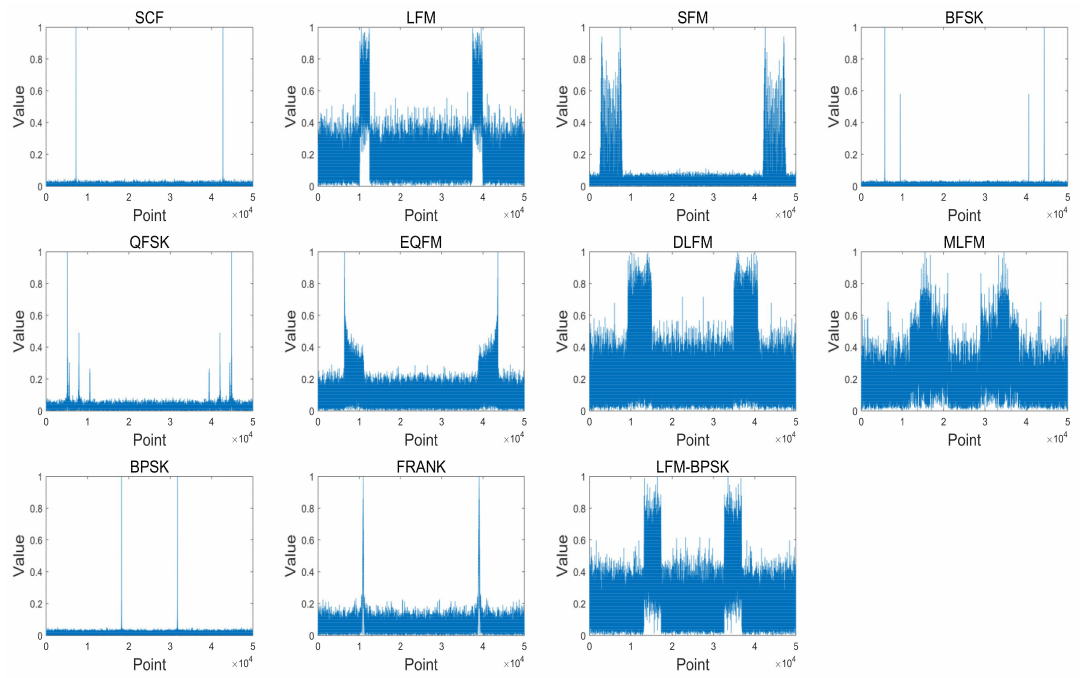
Figure 4. The frequency-domain amplitude spectra of the same samples in Figure 3 after data preprocessing stage where the length of x padded is set to